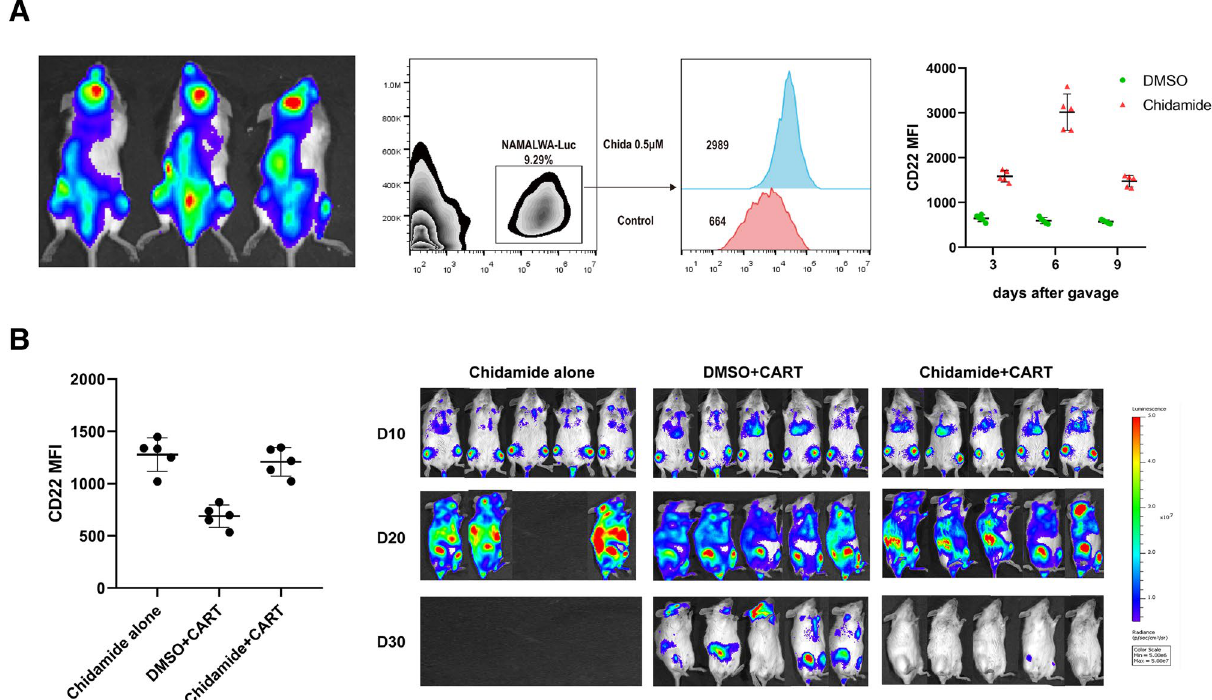
Figure 3. Chidamide increases CD22 antigen expression and bolsters antitumor effects of CAR T cells in vivo. ( A ) A NAMALWA-xenograft mice model was constructed and the GFP + Luciferase + NAMALWA cells were detected in peripheral blood. When given by orally administrated with Chidamide at a final concentration of 3 mg/kg for 3 days, the MFI of CD22 on the surface of tumor cells was measured at days 3, 6 and 9 after gavage. ( B ) NSG mice were injected with GFP + Luciferase + NAMALWA cells on Day 0, DMSO control and Chidamide was orally administrated at day 10 for 3 days and CD22 CAR T cells were injected on Day 13 after detecting the MFI of CD22 on the surface of tumor cells. Leukemia progression was monitored using IVIS technology and luciferin-D IP